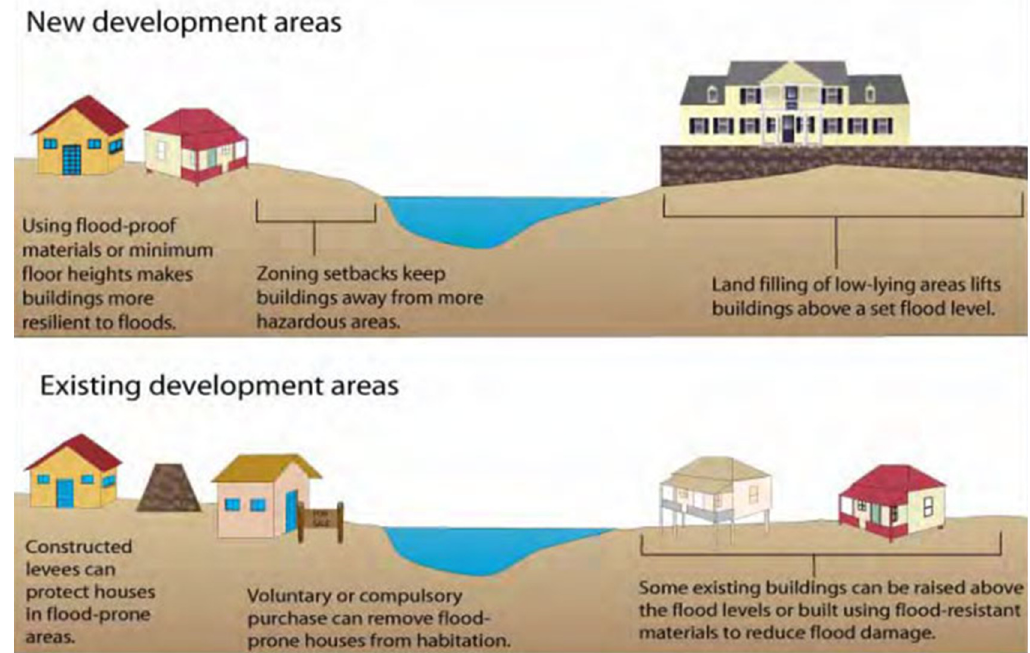
Figure 10. Flood mitigation measures for new and existing developments.